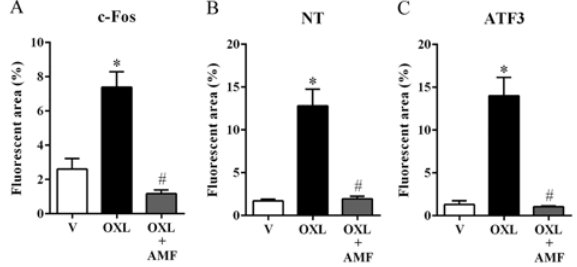
Figure 2. Fluorescent area quanti fi cation of c-Fos, nitrotyrosine (NT), and activating transcription factor 3 (ATF3) expression in the dorsal root ganglia of mice. The data are reported as means ± SE of the percentage of positive fl uorescent areas of c-Fos ( A ), NT ( B ), and ATF3 ( C ) expression concerning NeuN (neuronal marker) expression on the 28th experimental day. *P o 0.05 vs